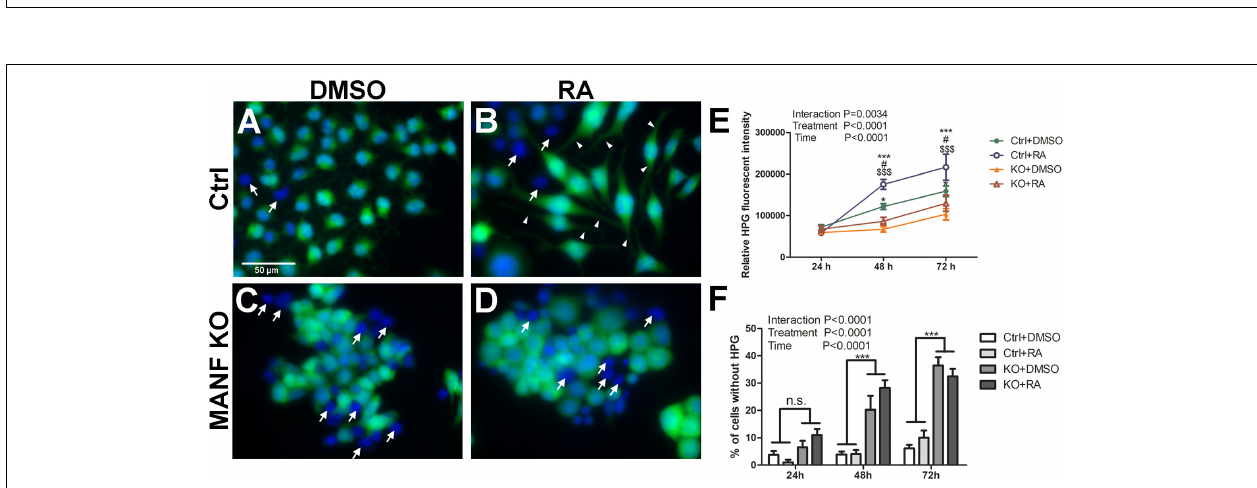
FIGURE 9 | Pharmacological activation of Akt, Erk, and mTOR partially rescues neurite outgrowth defects in MANF KO cells in response to RA. (A) Representative images of MANF KO cells treated with DMSO or RA or RA+Akt and Erk activators for 3 days. Cells were fixed and stained with crystal violet for visualization. Red arrows indicate cells with neurite outgrow in response to RA treatment. (B) Average neurite length was measured, and analyzed by One-way ANOVA followed with the Tukey’s post hoc test, *** P < 0.0001. The data were expressed as the mean ± SEM of three independent experiments.